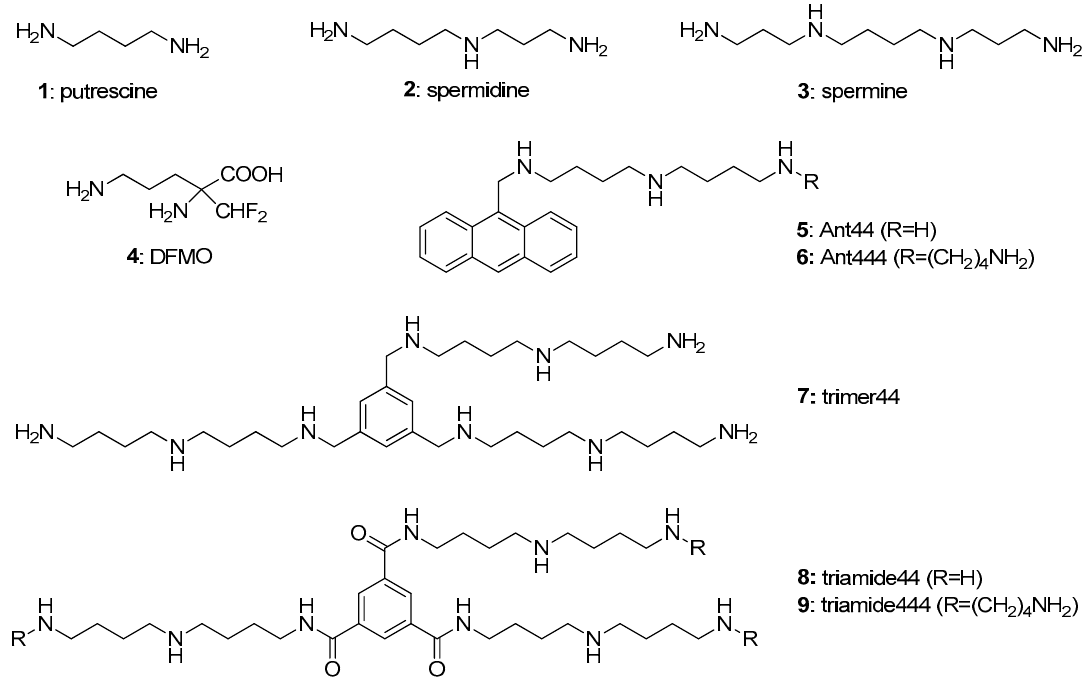
Figure 1. Structures of the native polyamines ( 1 – 3 ), difluoromethylornithine (DFMO) ( 4 ), polyamine analogue ( 5 ) and candidate polyamine transport inhibitors (PTIs; 6 – 9 analogue ( 5 ) and candidate polyamine transport inhibitors (PTIs; 6 – 9 ).